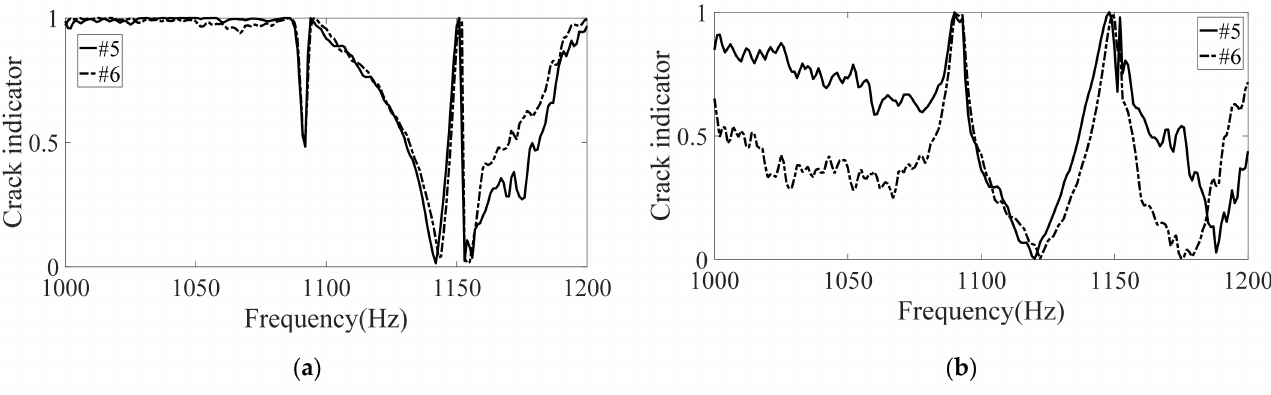
Figure 11. Crack indicator in X-Z plane: ( a ) frequency response function and ( b ) acceleration only. The same coherence function was used with response data alone for crack detec- tion, and the results for the cracked and the uncracked face (see Figure 3) are shown